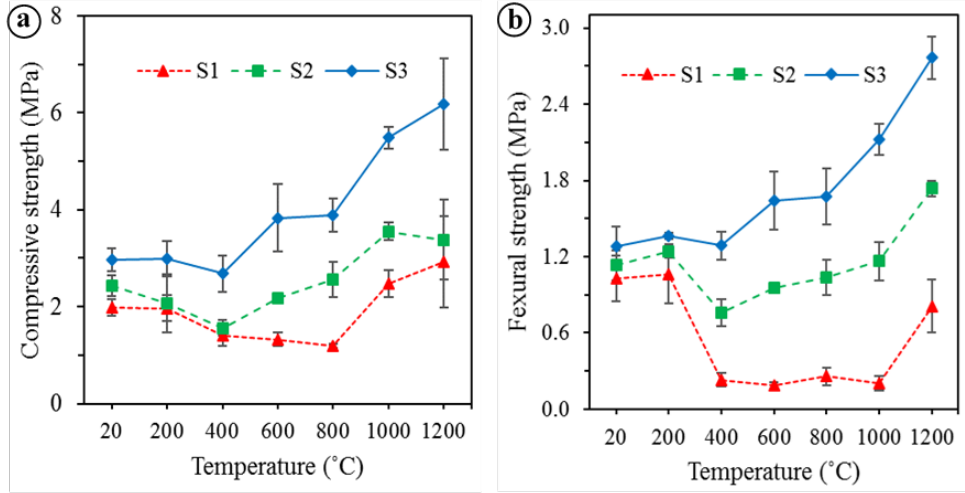
Figure 5. ( a ) Compressive strength and ( b ) flexural strength of the BGFs at different temperatures